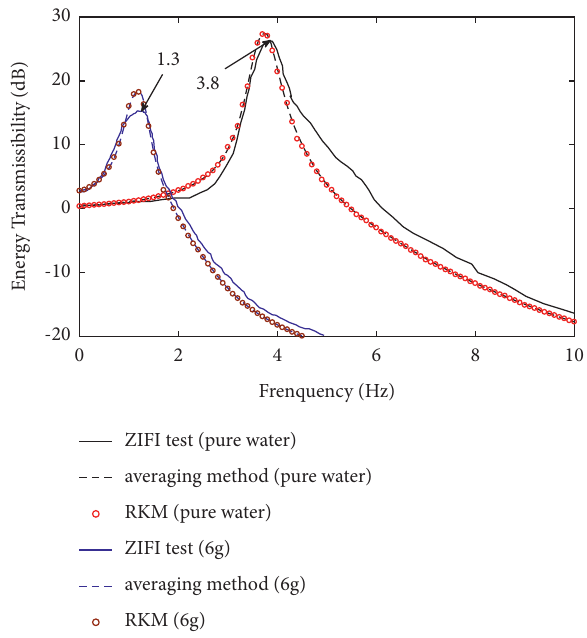
Figure 9: Energy transmissibility curves of the